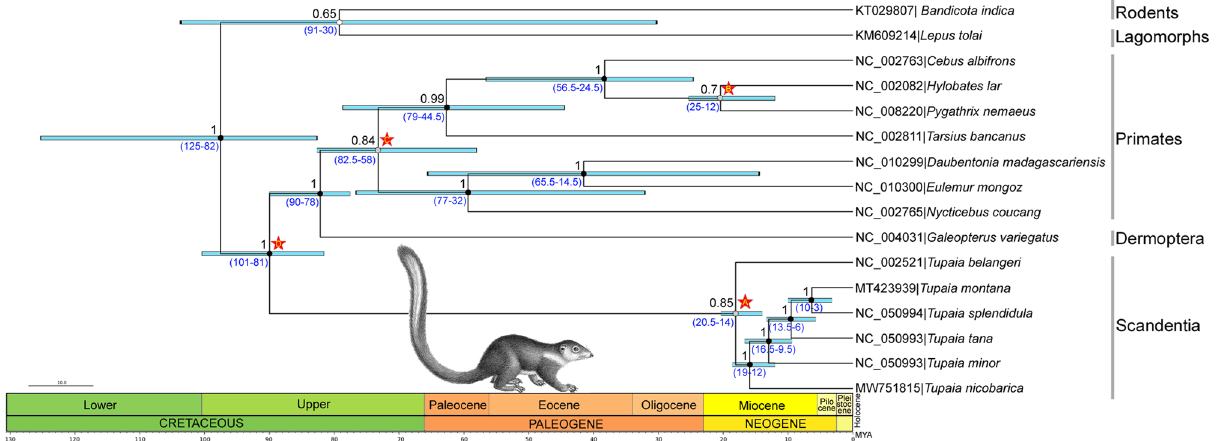
Figure 3. Bayesian inference showed the molecular timescale for Tupaiidae species evolution compared with other Primates and Dermoptera species as well as Lagomorphs and Rodents as out-group. Posterior probabilities were represented by black digit along with each node. The divergence times (in MYA) were estimated by four calibration points (marked by red stars) with GTR + I + G substitution model and relaxed uncorrelated log- normal clock with the Yule speciation model in BEAST v2.4.7. Blue bars represent 95% highest probability density (HPD) around mean estimates of divergence times. The range of the estimated divergence times were marked by values in blue along with each node. Treeshrew artwork was acquired from web (https:// www. wpcli part. com; Paul Sherman) and edited manually in Adobe Photoshop CS